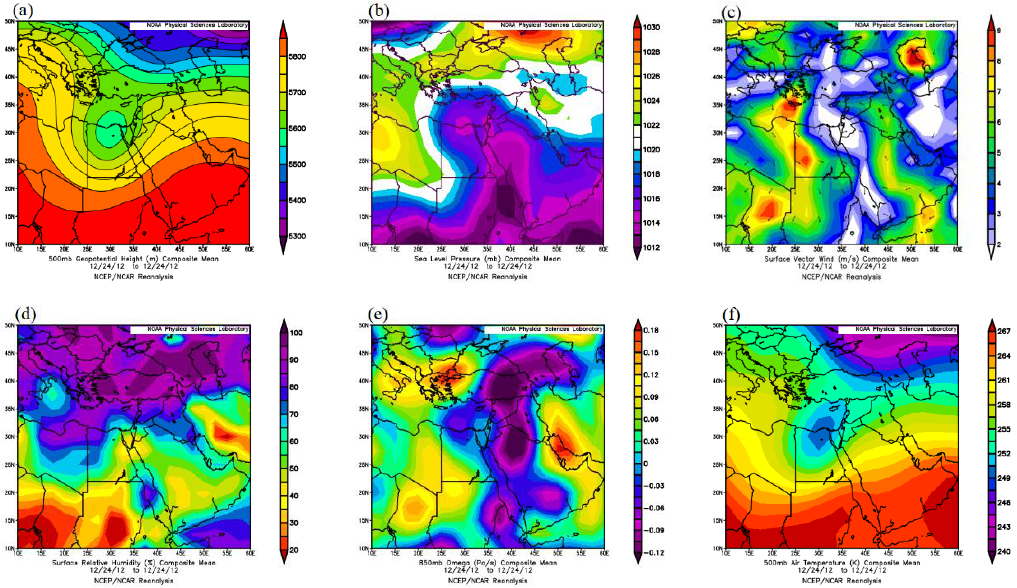
Figure 3: The weather chart for 24 December 2012, (a) 500 mb geopotential height (m), (b) sea level pressure (mb), (c) surface wind (m/s), (d) surface relative humidity (%), (e) 850 mb omega (pa/s), and (f) temperature (k) at 500